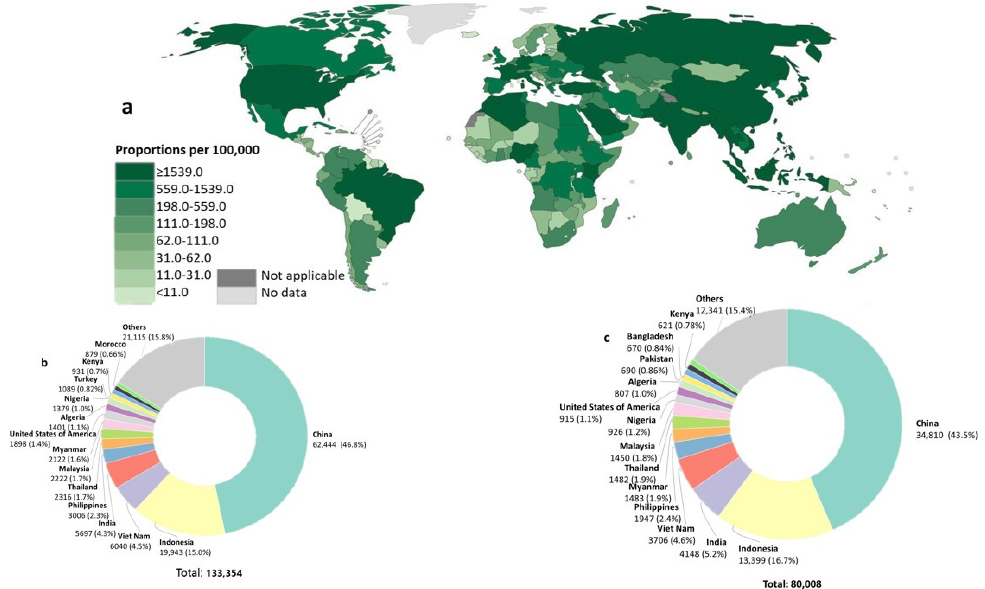
Figure 1. Worldwide distribution of NPC in 2020. ( a ) Map view of estimated number of NPC prevalent cases (5-year) in 2020. Estimated number of ( b ) new cases and ( c ) mortality in 2020. Data from GLOBOCAN